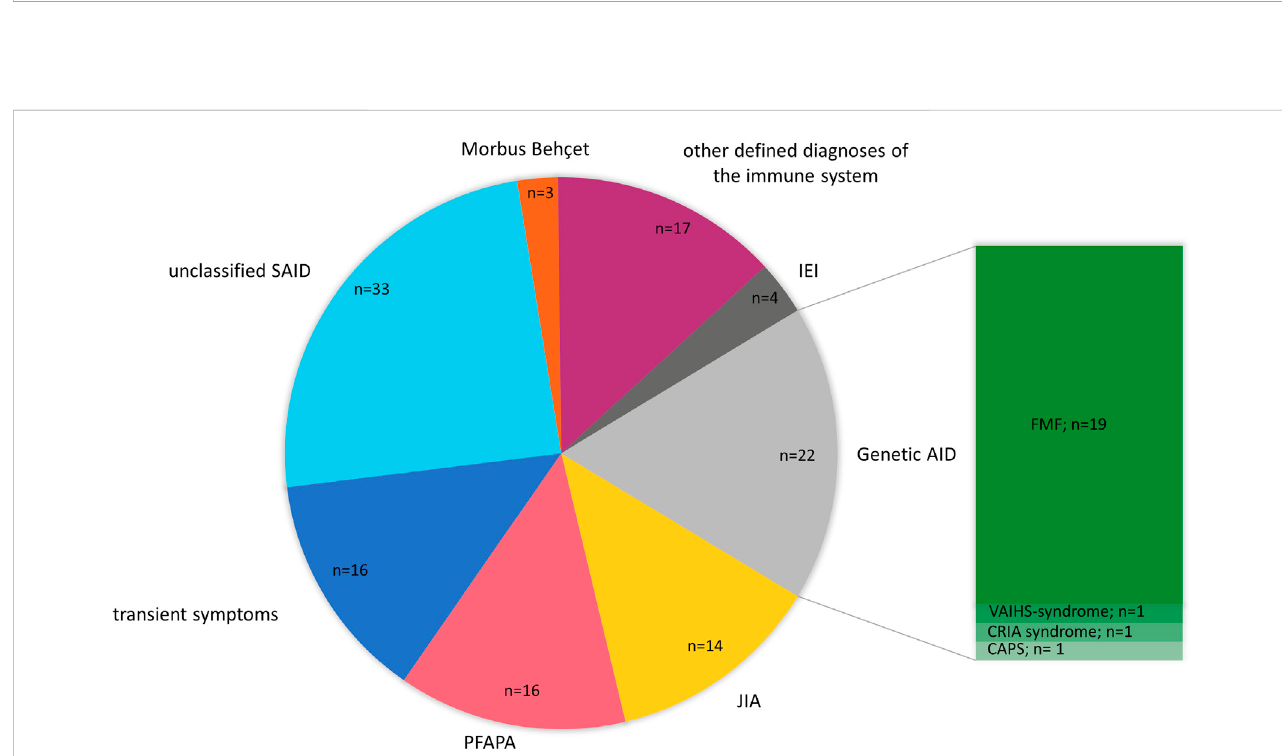
FIGURE 2 Final diagnosis of pediatric AID cohort after genetic testing. The pie chart is presenting the fi nal diagnosis of 125 pediatric patients with AID categorized into the following subclasses: Genetic autoin fl ammation (AID), juvenile idiopathic arthritis (JIA), PFAPA, patients with transient symptoms, unclassi fi ed SAID, Mobus Behçet, other de fi ned disease of the immune system (no genetic cause identi fi ed) and Inborn Errors of Immunity (IEI) (other than autoin fl ammation). AID was subdivided into FMF, VAIHS-syndrome, CAPS and CRIA syndrome. n = amount of